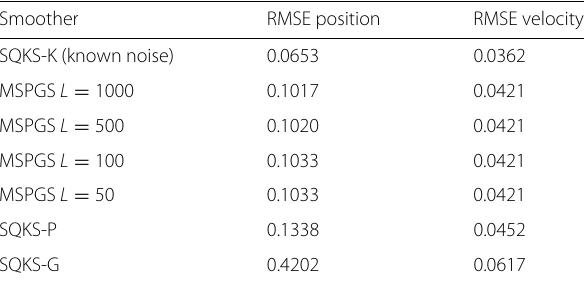
Table 1 Mean RMSE of position and velocity versus Monte Carlo